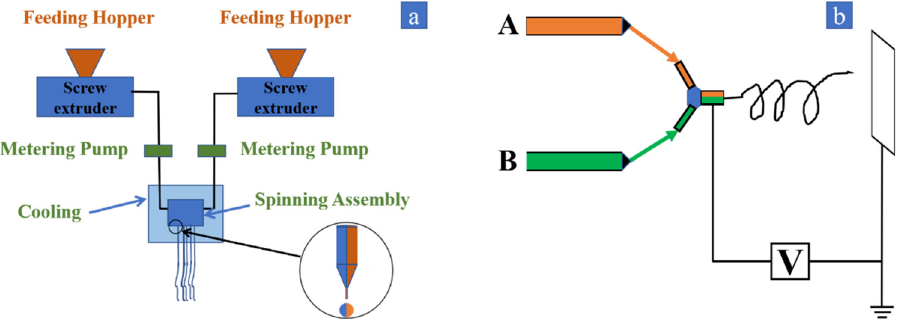
Figure 1: Schematic diagram of the preparation of side - by - side bicomponent fi bers by direct feeding: ( a ) melt spinning and ( b ) electro - spinning ( 87 ) .